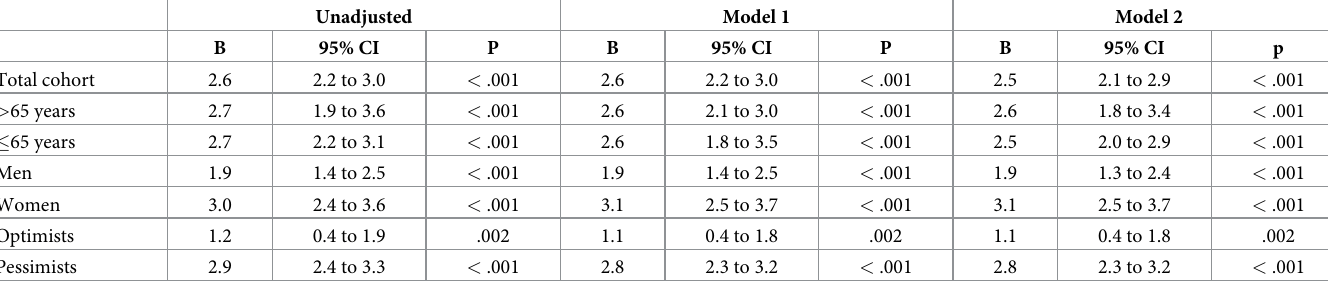
Table 2. Association between presence of important life events (yes vs no) and depressive symptoms.